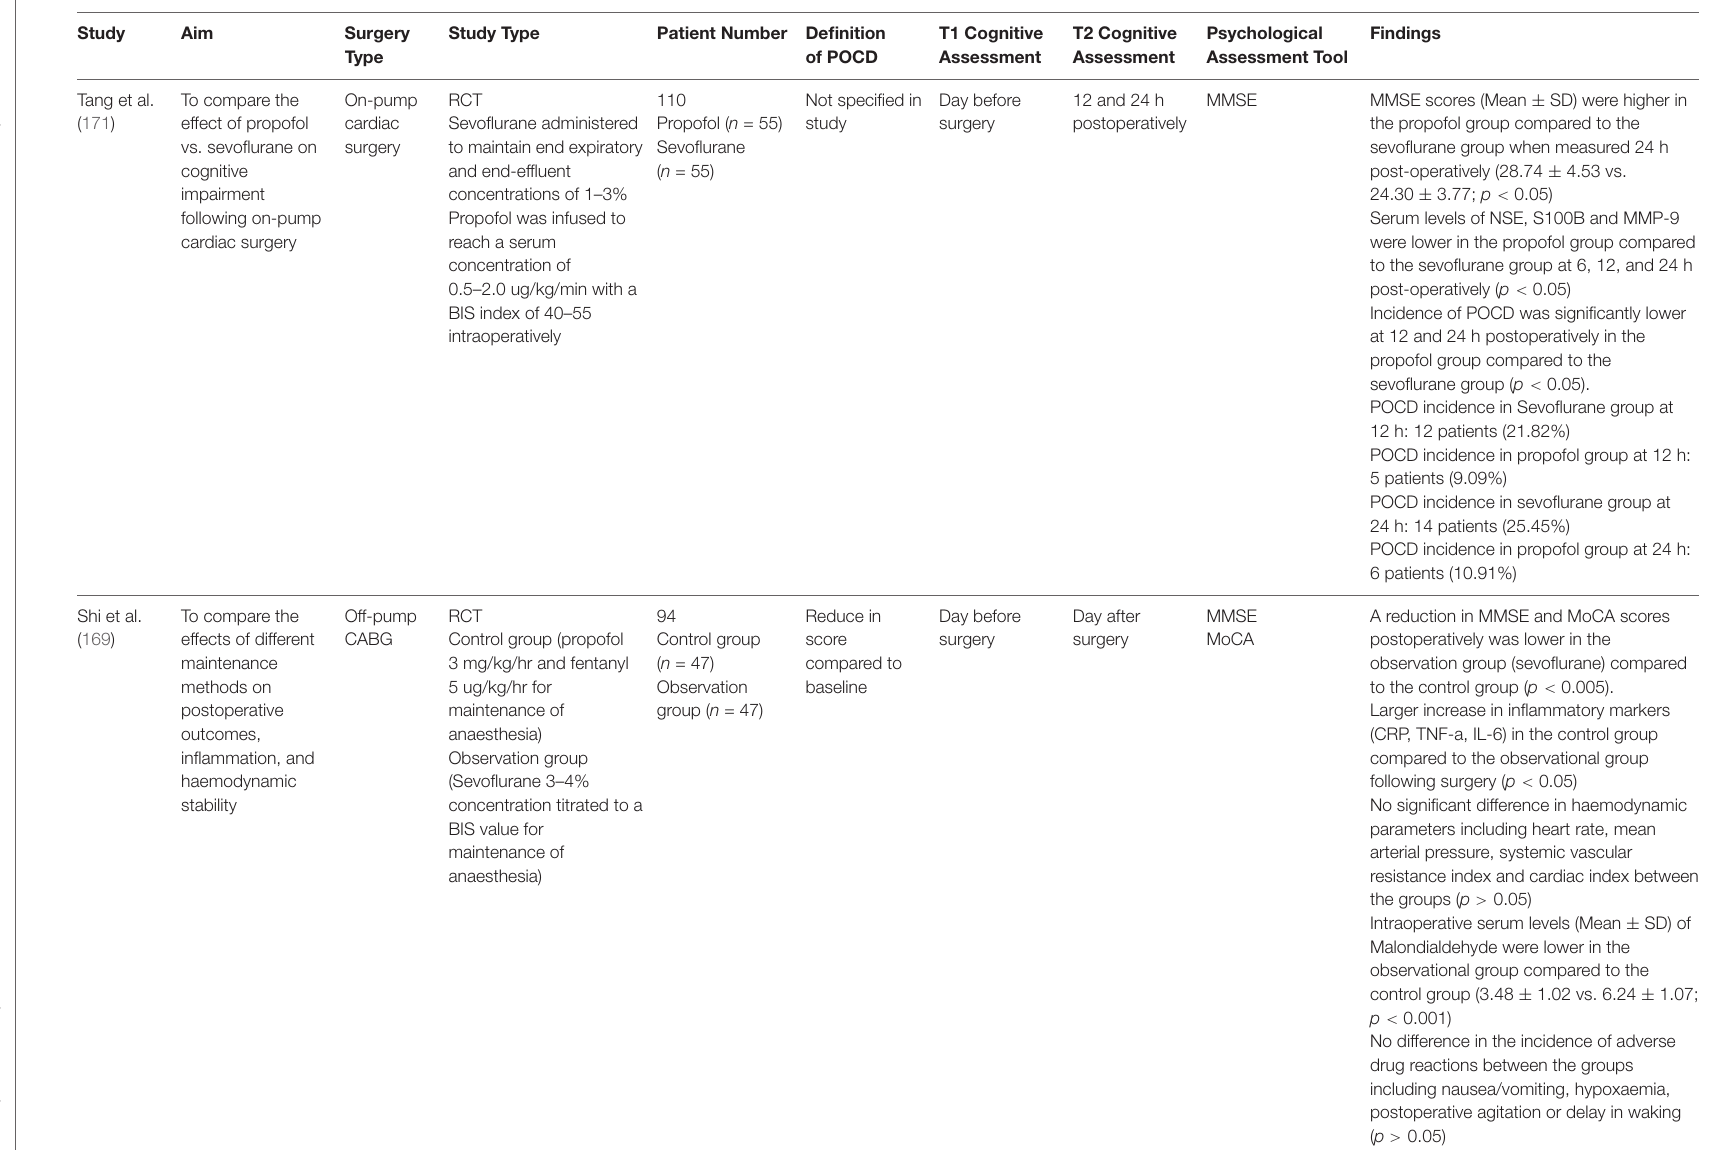
TABLE 7 | Studies assessing the effect of anaesthesia on cognitive impairment following cardiac